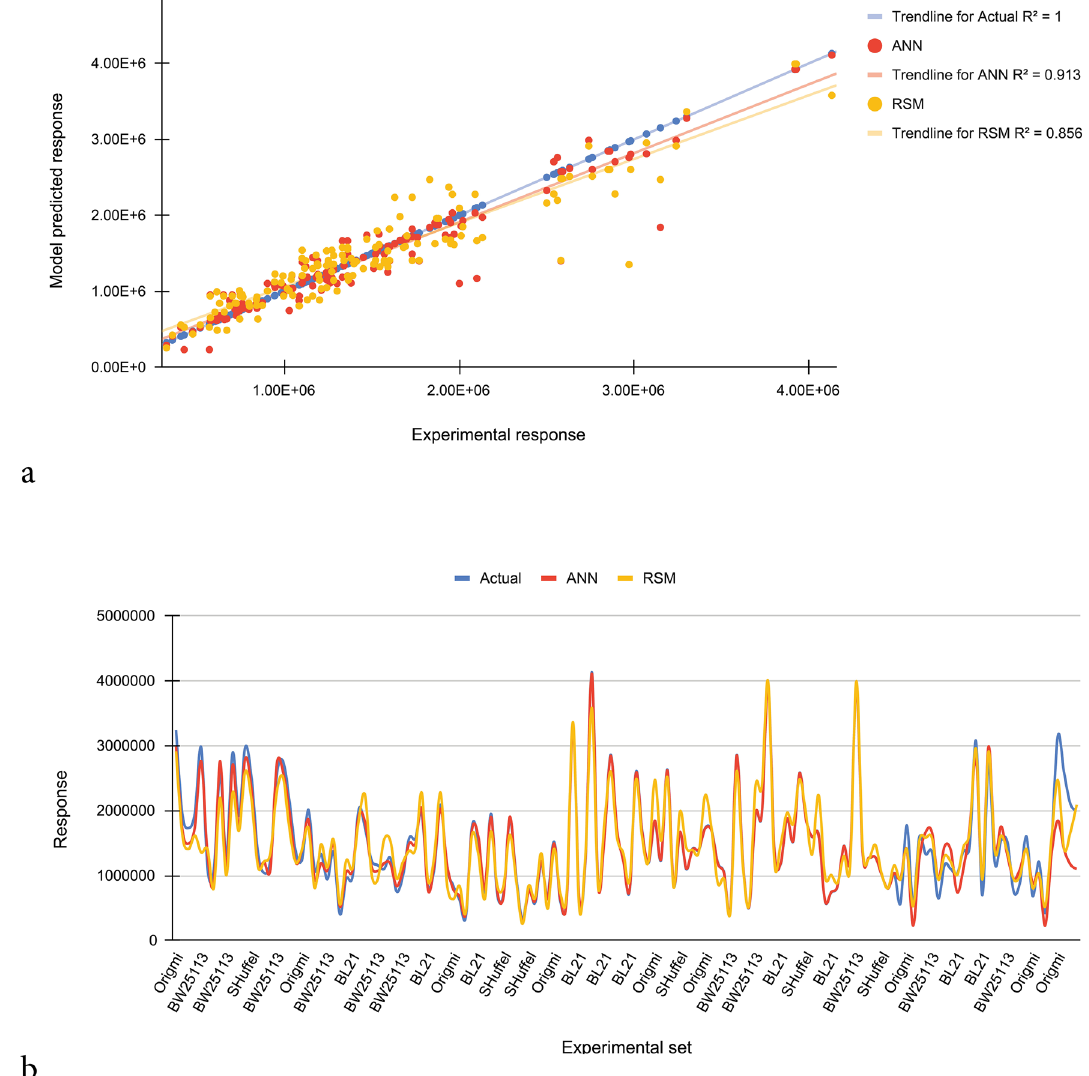
Figure 5. Comparison of prediction capabilities of RSM and ANN models for randomly selected dataset. ( a ) RSM and ANN predicted vs. actual responses. ( b ) Comparison of responses obtained from experimental, RSM and ANN. The ANN model has fitted the experimental responses with an excellent accuracy. Greater deviation is seen in RSM-based prediction for soluble production of scFv than ANN.